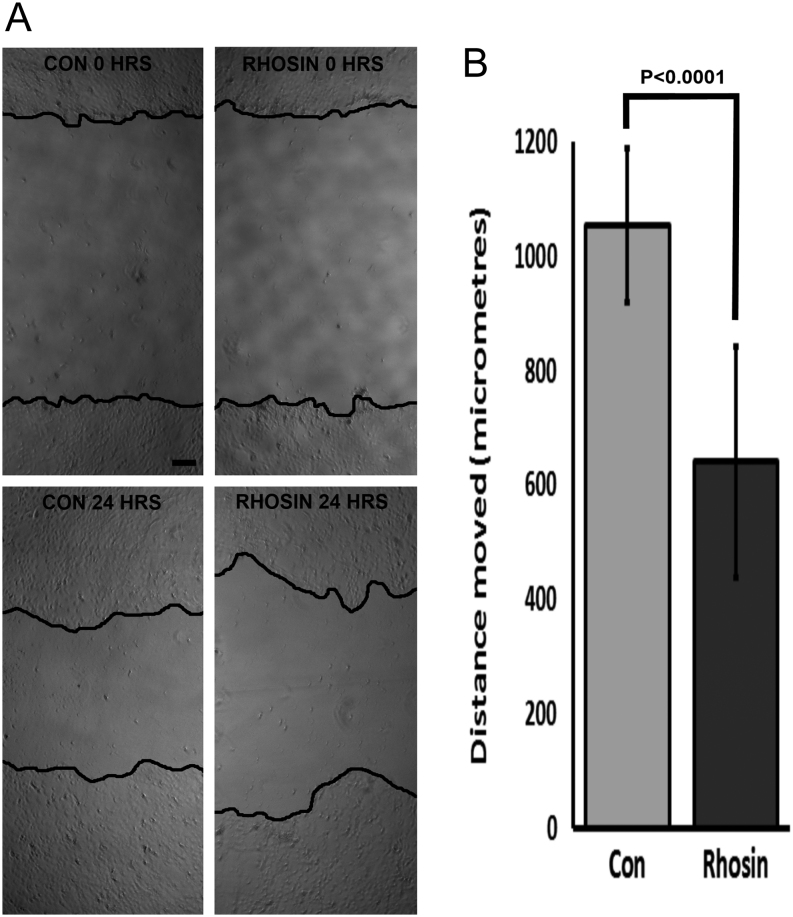
Inhibition of Rho function decreases motility of primary equine trophoblast cells. (A) Representative images of scratches at time 0 and 24 h in the absence and presence of Rho inhibitor (Rhosin, 50 µM). Black lines in each image mark the margins of the scratch and show a decreased motility following Rhosin treatment. (B) Cumulative data of average distance moved showing significantly (P < 0.0001) decreased motility in Rhosin treated cultures compared with control. Data shown are mean and standard deviation for 24 measurements (n = 3 independent experiments in day 34 chorionic girdle trophoblast). Scale bar in A represents 200 µm.